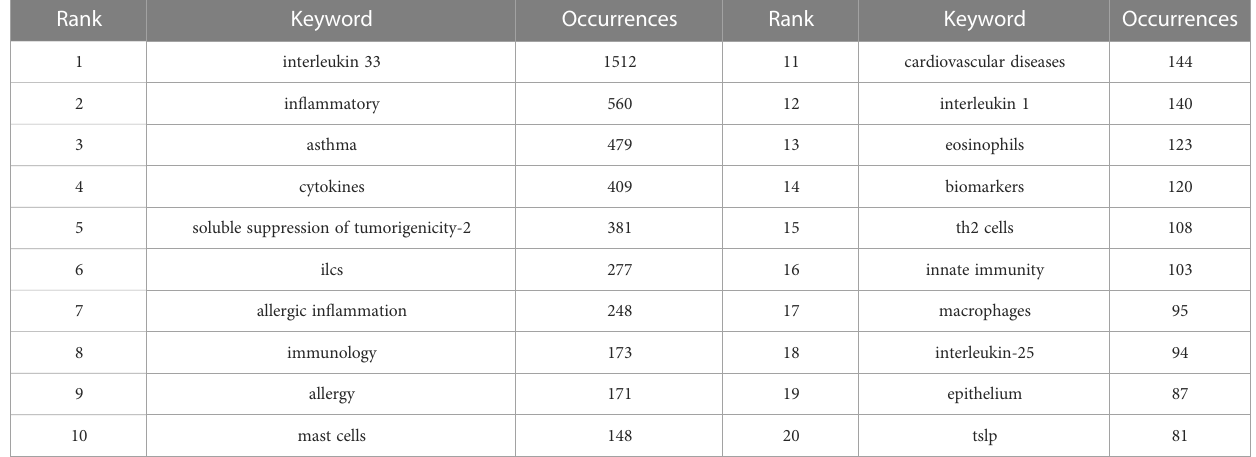
TABLE 6 The top 20 keywords in terms of frequency of occurrence concerning IL-33.